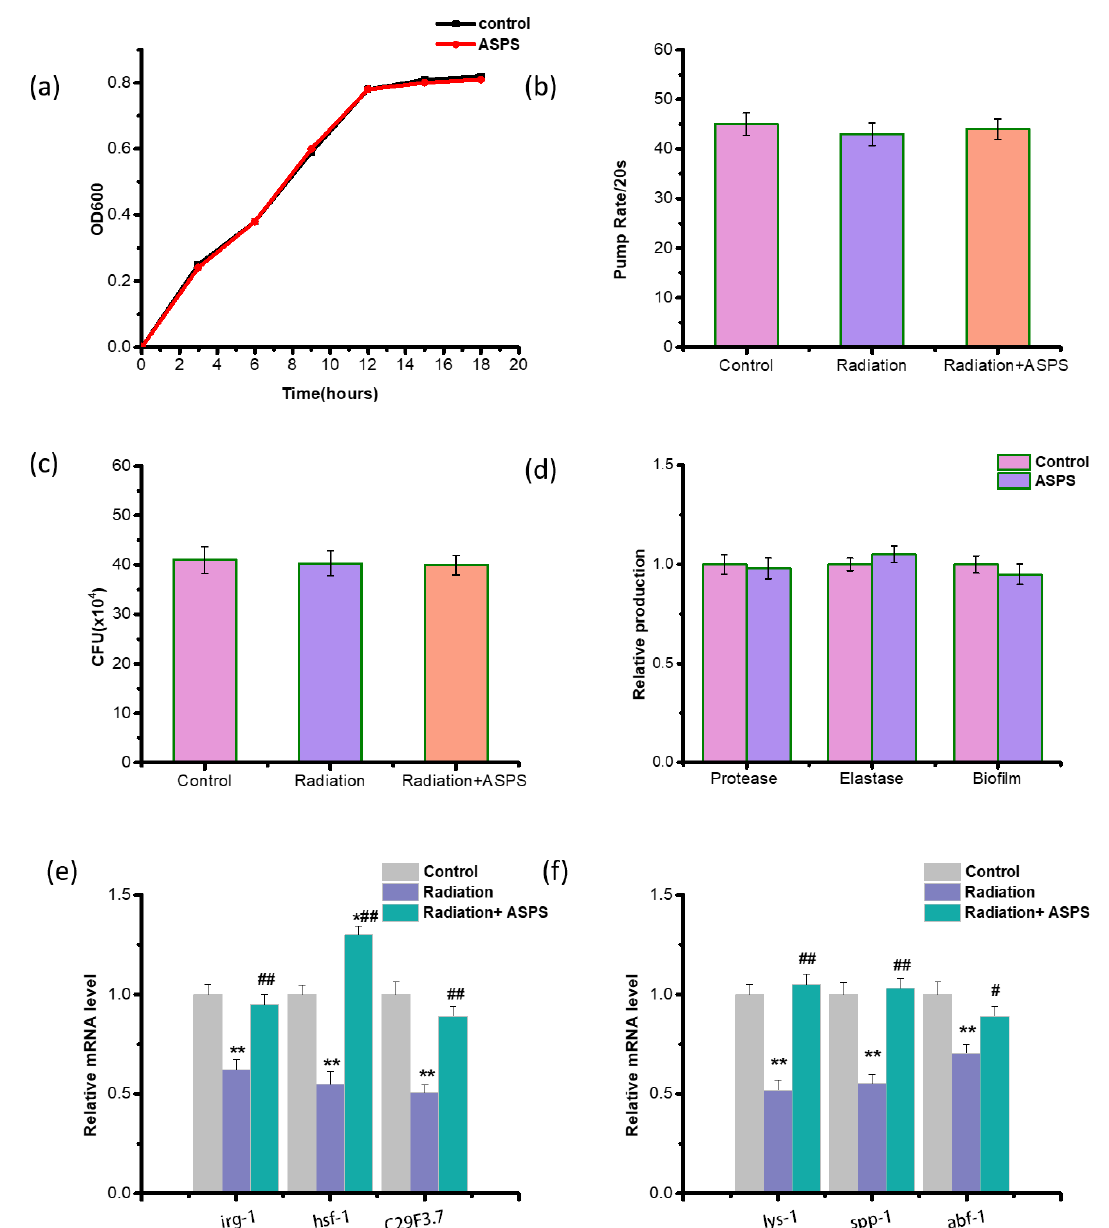
Figure 3. ASPS protected radiation-damaged nematodes against PA14 by elevating innate immune response. ( a ) PA14 growth curve in the presence of 1mg/mL ASPS. n = 3. ( b ) Pharynx pump rate of nematodes at 24 h after PA14 infection. n = 20. ( c ) Colony-forming units (CFUs) of PA14 in nematodes at 24 h after PA14 infection. n = 3. ( d ) PA14 virulence factors (protease activity, elastase activity and biofilm formation). PA14 was cultured at 37 °C for 24 h with or without ASPS. n = 3. ( e ) Early immune response genes. The genes were measured at 12 h after PA14 infection. n = 3. ( f ) Late immune response genes. The genes were measured at 24 h after PA14 infection. n = 3. Significant difference from the control group was designated as * p < 0.05 and ** p < 0.01, and significant difference from the radiation group was designated as # p < 0.05 and ## p < 0.01, respectively.